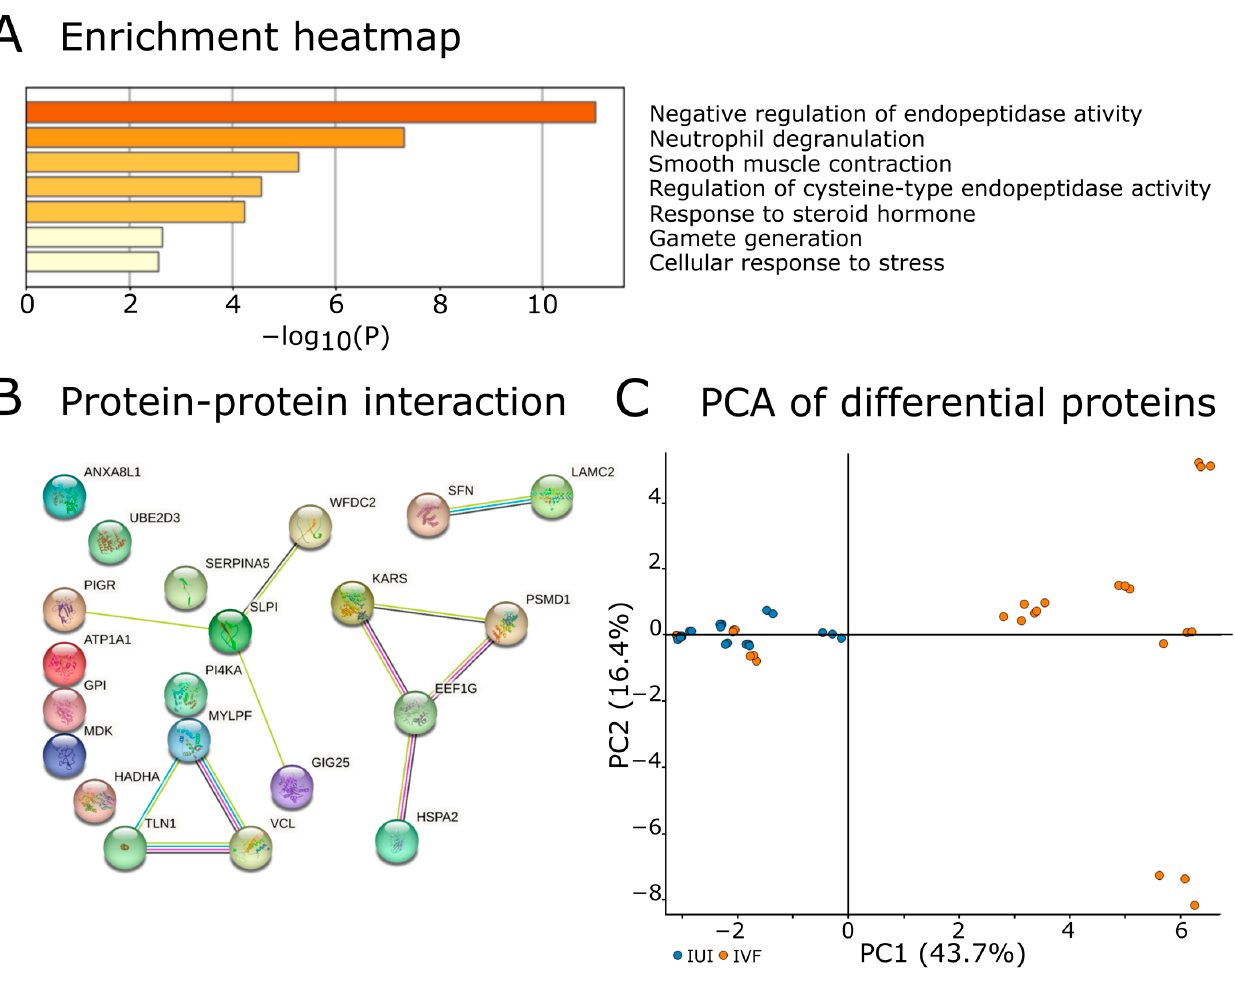
Figure 3. Annotation of proteins with Wilcoxon scores below 0.05. The biological annotations were used to generate an enrichment heatmap with Metascape ( A ) and to map protein–protein interactions ( B ). The PCA plot ( C ) shows the distribution of differentially expressed proteins with Wilcoxon p values below 0.05 in the IUI and IVF samples.